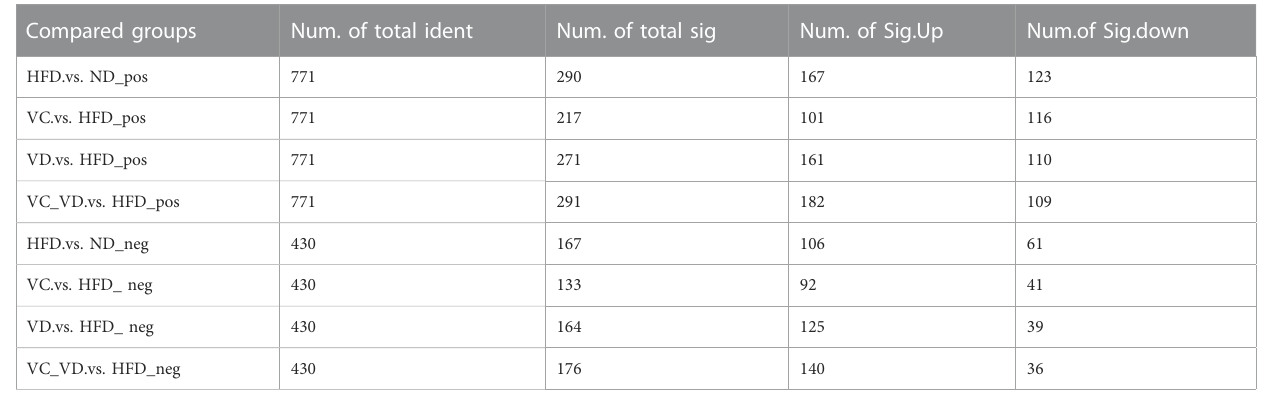
TABLE 2 Differential metabolite screening results. Compared groups Num. of total ident Num. of total sig Num. of Sig.Up Num.of Sig.down